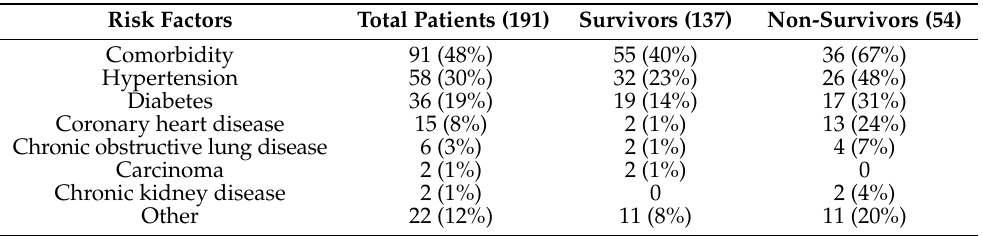
Table 3. Percentage of risk factors between survivors and non-survivors (associated with the severity of SARS-CoV-2)